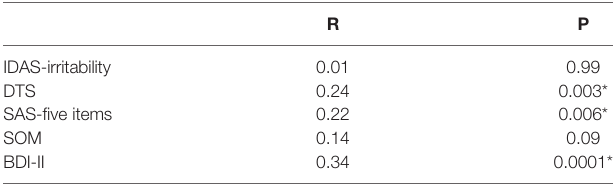
TABLE 6 | Pearson correlations between craving and psychometric results. * = signi fi cant after Bonferroni correction (p corrected = 0.01). R P IDAS-irritability